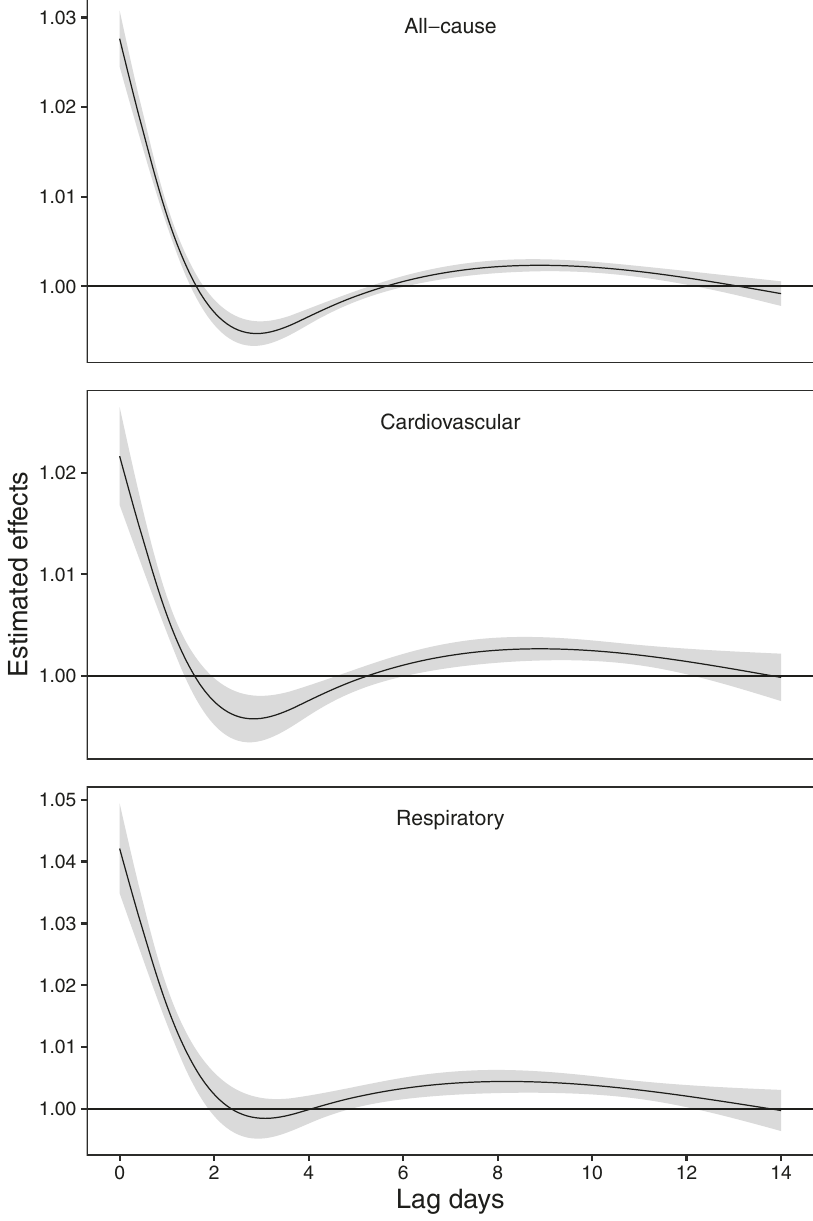
point-estimates and shaded areas denote the corresponding 95% con fi dence intervals. Note 2: estimates were derived from models with data in 510 immediate regions. Note 3: PM 2.5 , fi ne particulate matter with diameter ≤ 2.5 μ